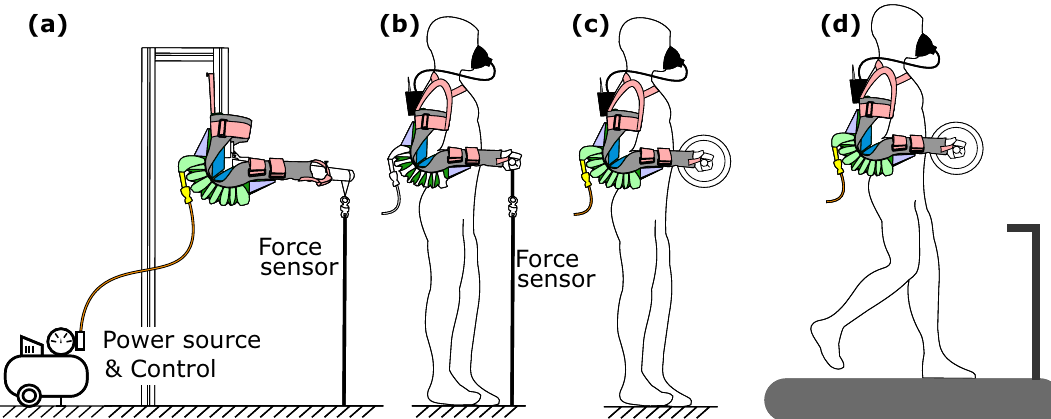
Figure 7. Carry exoskeleton experimental setups for investigating: ( a ) the relations between elbow flexion torque and pneumatic actuator air pressure during bench testing, ( b ) MVIC as a measure for fatigue, ( c ) changes in muscle activity in the short holding scenario (5 kg, 10 kg and 15 kg), and changes in muscle activity and metabolic cost in the long holding scenario, and ( d ) changes in muscle activity and metabolic cost in the carrying scenario. The power source and electronics were placed offboard in all